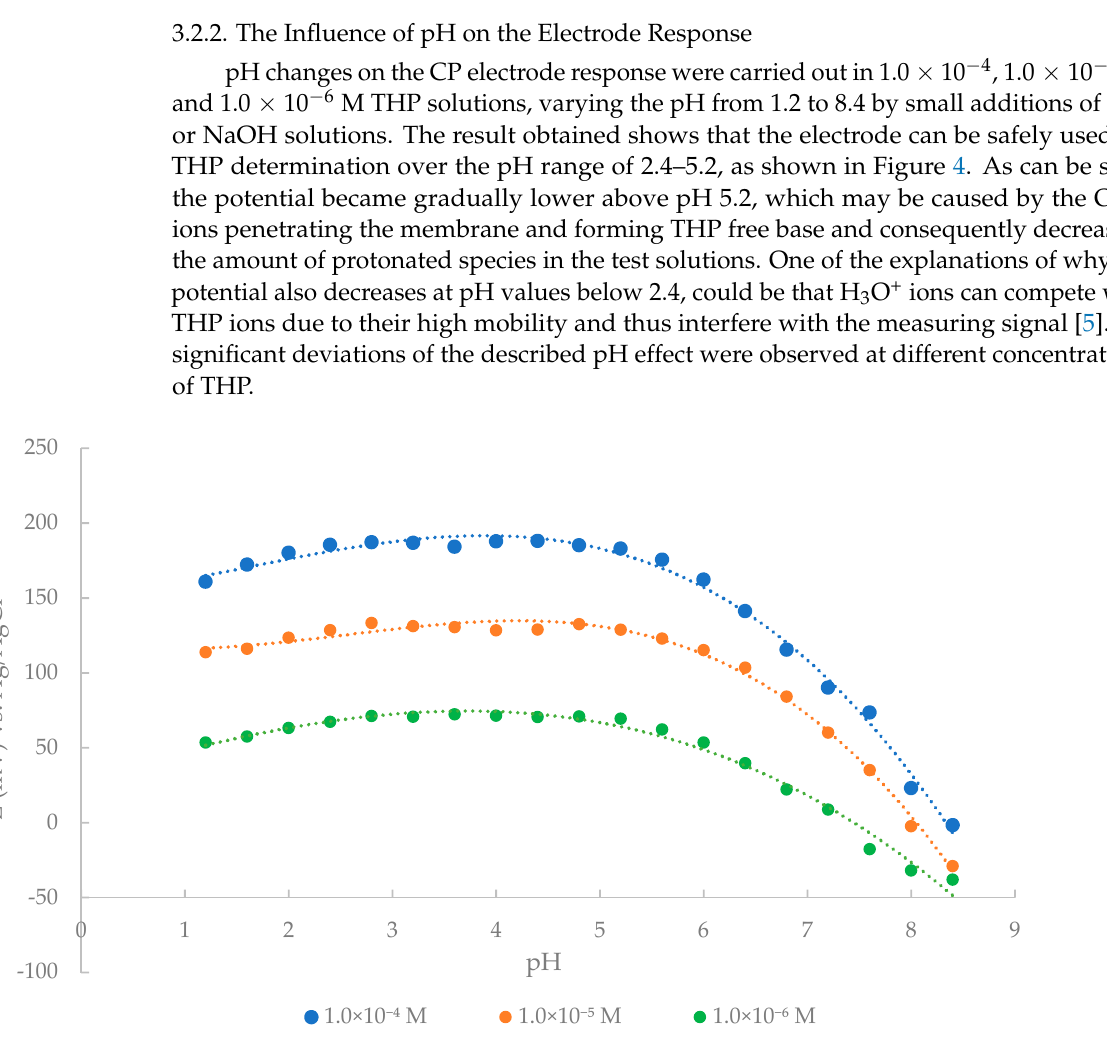
Figure 4. Effect of pH on the potential response of the proposed CPE.